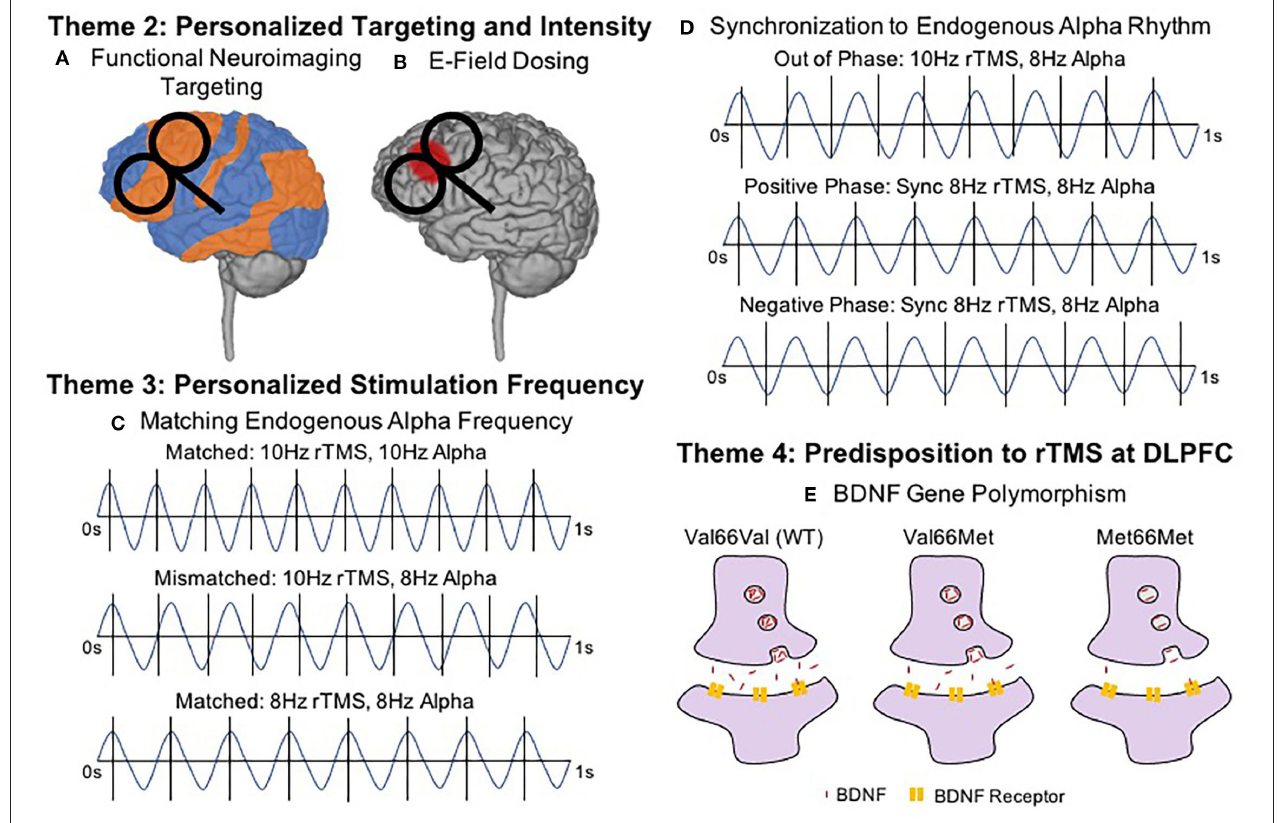
FIGURE 2 | Key Brain States and Predispositions To Consider in Next Generation rTMS Therapies. (A) Functional Neuroimaging Targeting (Resting State Functional Connectivity; rsFC Targeting and concurrent TMS-fMRI). Target selection may become personalized based on functional connectivity and/or symptoms. Combining single pulses of TMS and measuring the blood oxygen level dependent (BOLD) signal may further help to individualize stimulation targets and possibly predict treatment course outcomes. (B) Electric Field (E-Field) Dosing. Intensity selection may utilize realistic head models and MRI-based E-field dosing to more precisely estimate the stimulation delivered to the target, particularly outside of the motor cortex. (C) Matching Endogenous Alpha Frequency. Patients with endogenous alpha rhythms closer to (or at) 10Hz (top) responded better to 10Hz rTMS than patients who were mismatched (middle). Most effective rTMS may involve stimulation at the endogenous frequency (bottom). (D) Synchronization to Endogenous Alpha Rhythm. Through closed-loop EEG, synchronized delivery of each rTMS train with an individualized endogenous alpha rhythm and aligning the timing of the TMS pulse with a specific phase of the waveform appears to further optimize rTMS effects. Here we show synchronized rTMS-EEG in three phases. Out of Phase describes when pulses are delivered without regard to endogenous oscillations (e.g., 10Hz stimulation delivered for someone with endogenous 8Hz oscillations). When rTMS is delivered In Phase , the pulses can be synchronized with the peak of each oscillation (i.e., Positive Phase ) or at the trough of each oscillation (i.e., Negative Phase ). Importantly, synchronizing the endogenous alpha rhythm could occur at any frequency, e.g., 8.5Hz. (E) Predisposition to rTMS—BDNF Gene Polymorphism. Genetic predispositions may influence individual response to rTMS, such as the Val ??Met single nucleotide polymorphism found in the brain derived neurotrophic factor (BDNF) gene which impairs the normal plasticity response to rTMS